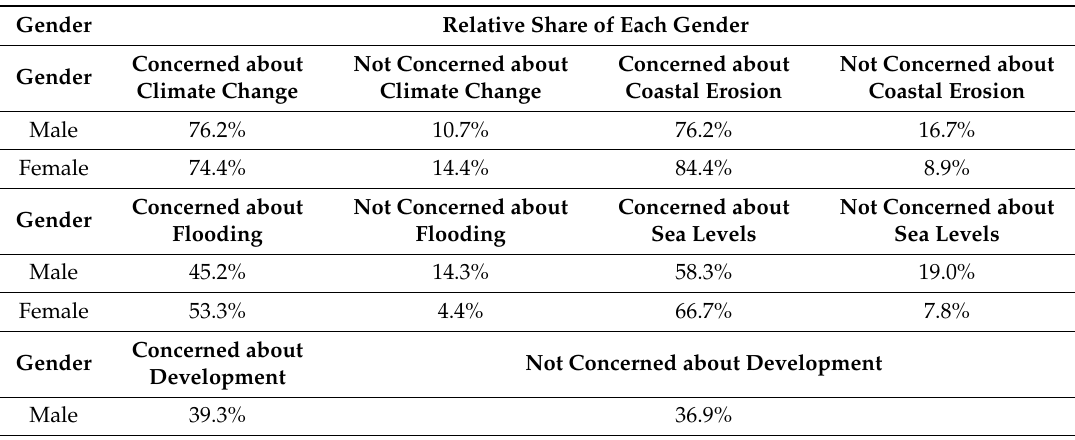
Table 6. Perceptions of environmental and social challenges by gender: St.